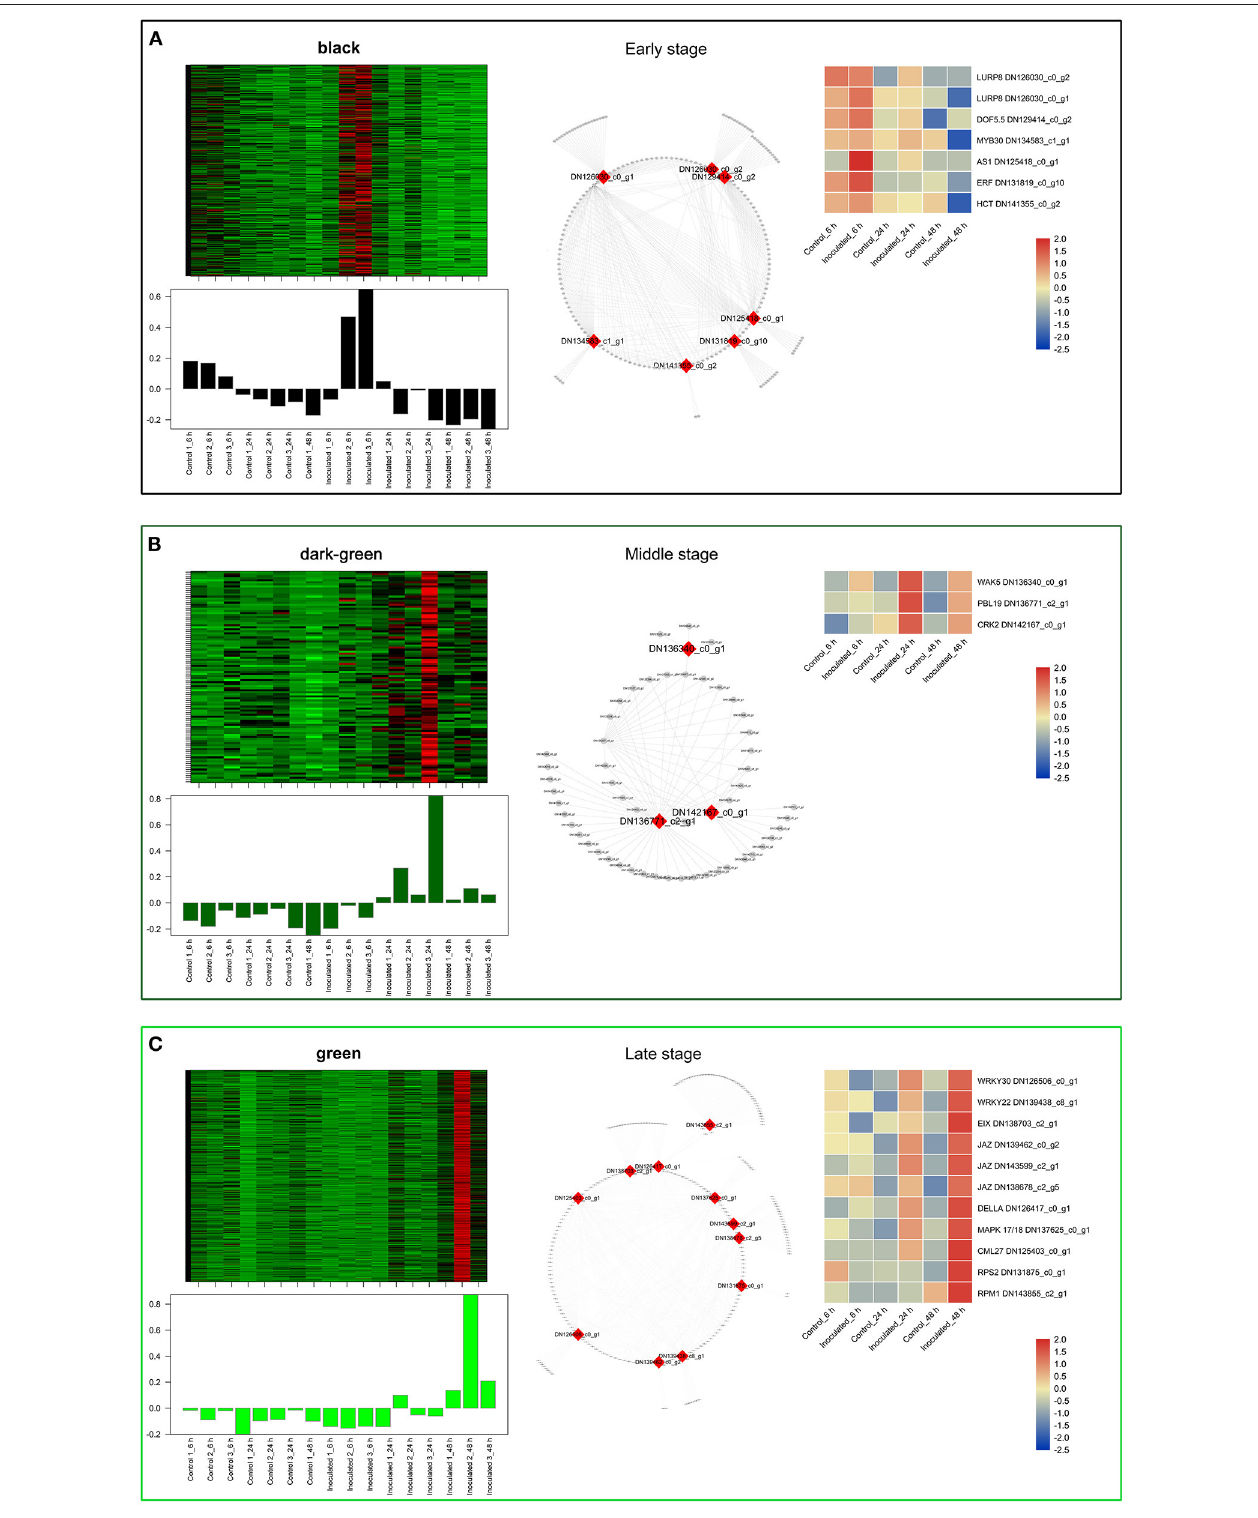
FIGURE 5 | “Sorbonne” DEGs identified at different stages of B. elliptica infection. (A–C) Co-expression network of the black module (A) , dark-green module (B) , and green module (C) . Heat maps and bar graphs show the co-expressed genes in each module (left). Red rectangles on the heat map denote high expression levels; green rectangles denote low expression levels. The network of top hub genes is indicated by red squares in the network (middle). Heat maps (right) show the expression patterns of hub genes.